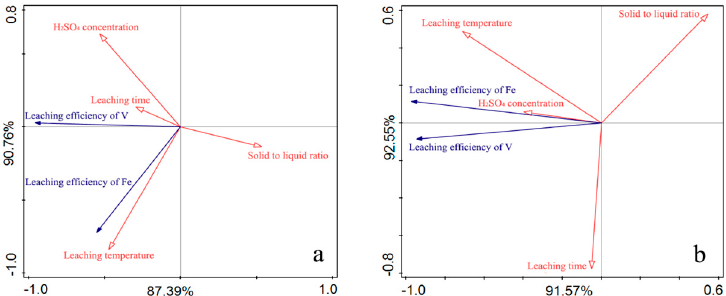
Figure 3. Redundancy analysis (RDA) of the leaching parameters and the leaching e ffi ciency of V Figure 3. R edundancy analysis (RDA) of the leaching parameters and the leaching efficiency of V and Fe. ( a ) the raw ore; ( b ) the roasted ore. and Fe. ( a ) the raw ore; ( b ) the roasted ore.